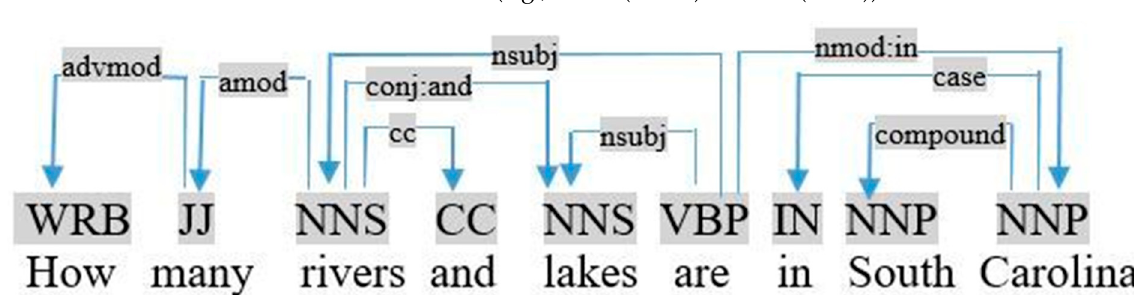
Figure 5. Graph dependency of the query «how many rivers and lakes are in South Carolina».